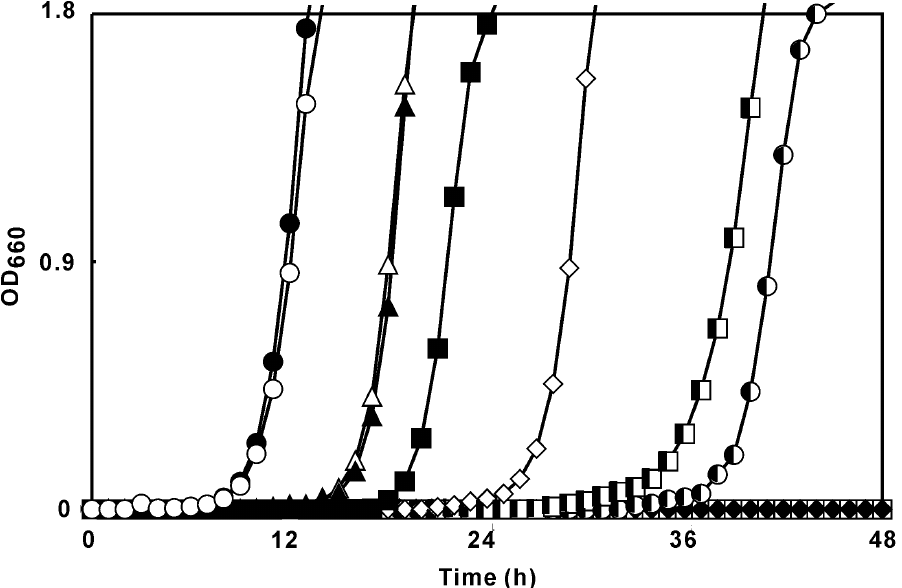
Figure 1. Inhibitory effects of long-chain fatty alcohols on the growth of S. aureus FDA209P. S. aureus FDA209P was inoculated into BHI medium that contained no long-chain fatty alcohols ( ), or into broth that contained 40 µ g mL -1 of 1-octanol ( ), 1-nonanol ( ), 1-decanol ( ), 1-undecanol ( ), 1-dodecanol ( ), 1-tridecanol ( ), 1-tetradecanol ( ), 1-pentadecanol ( ), 1-hexadecanol ( ), 1-heptadecanol ( ) or 1-octadecanol ( ), and then cell growth was monitored in terms of OD 660